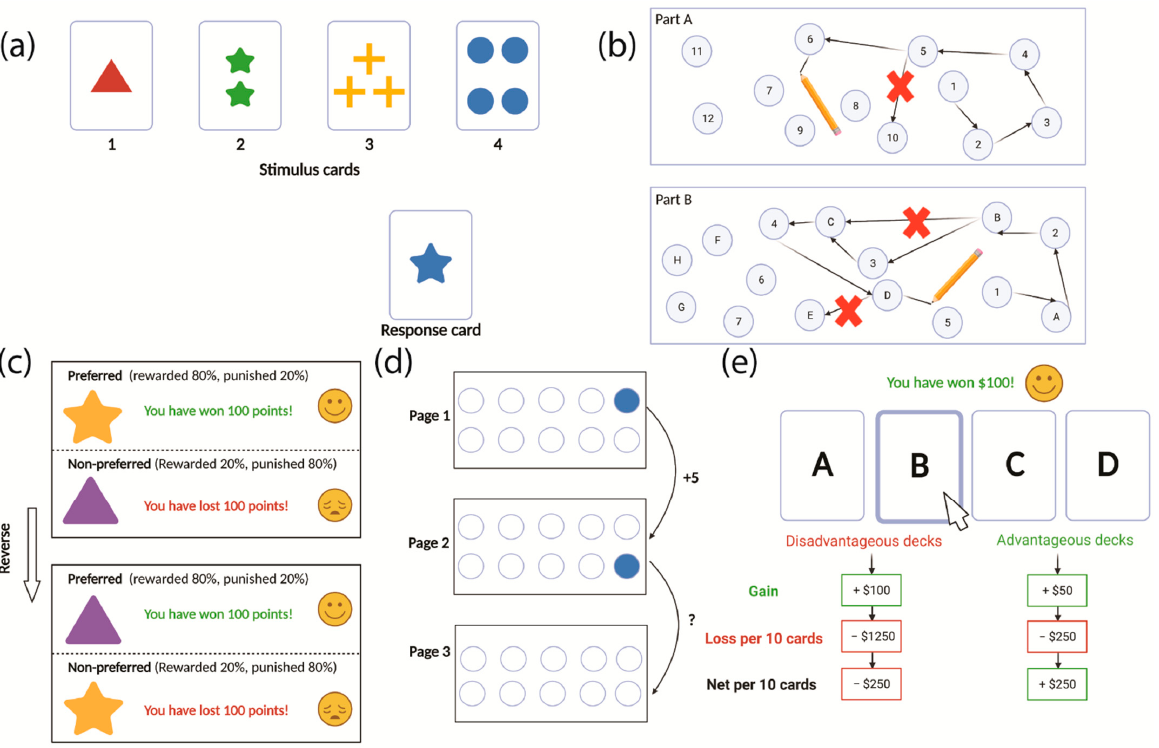
Figure 1. Common cognitive tests that are used to assess cognitive flexibility in humans. ( a ) The Wisconsin Card Sorting Task (WCST) is the most commonly used test in the examination of cognitive flexibility. Participants need to match the response card to the stimulus cards based on either colour, shape or number. The sorting rule changes after several consecutive correct matches without